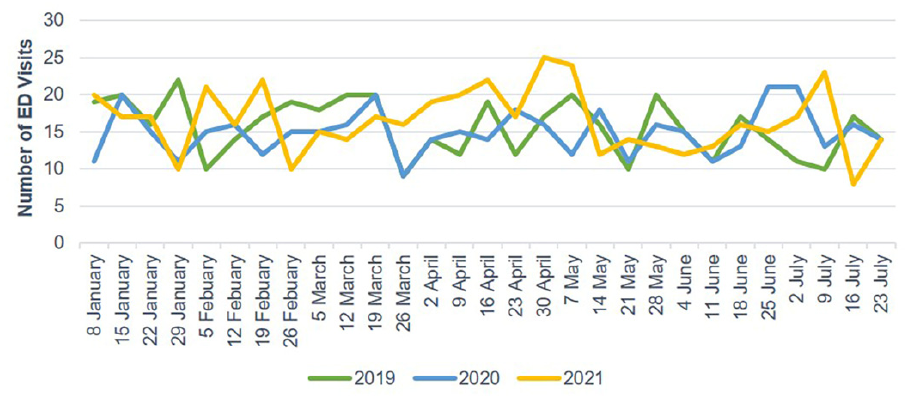
Figure 5. Weekly ED visits due to serious head injury from January to July 2019, 2020, and 2021. ED, emergency department.